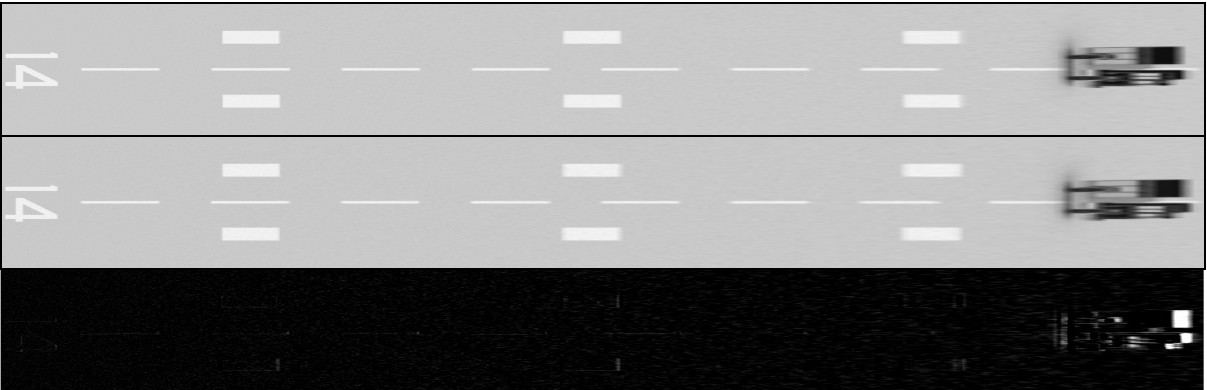
Figure 8. (a, upper) An example of an orthophoto with a foreign object (a firetruck) visible on the right side. (b, middle) Second orthophoto generated from the image captured from the different position of the camera. (c, down) Difference of